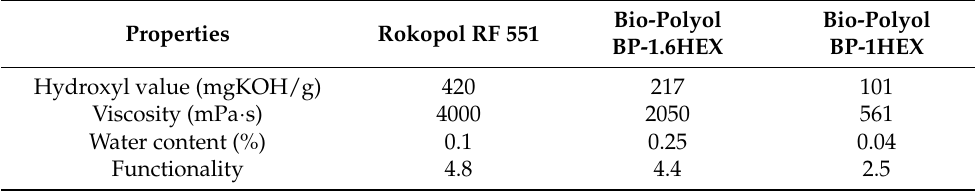
Table 1. Properties of